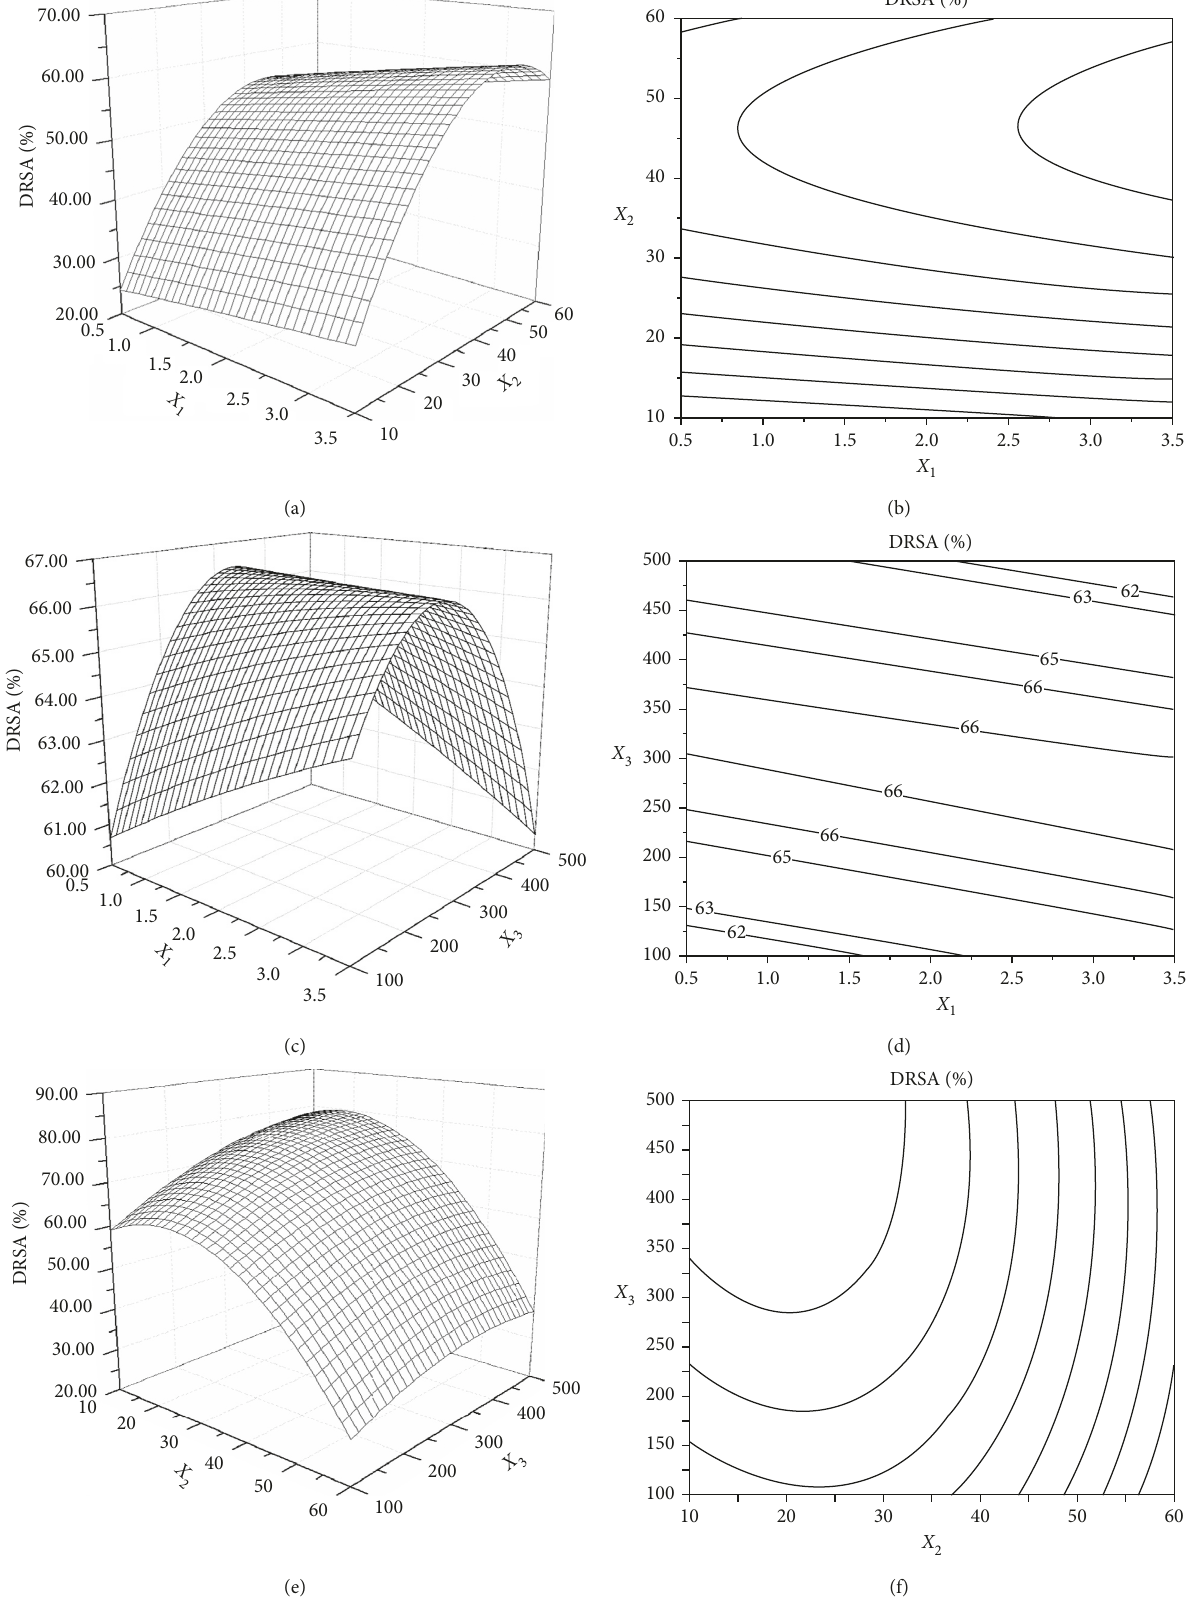
Figure 2: Response surface plots (a, c, and e) and contour plots (b, d, and f) for the effect of hydrolysis time ( X ), and protease dosage ( X ) on the DRSA. (a and b indicate the effect of hydrolysis time, c and d indicate the effect of substrate ( X 2 3 concentration, and e and f indicate the effect of protease